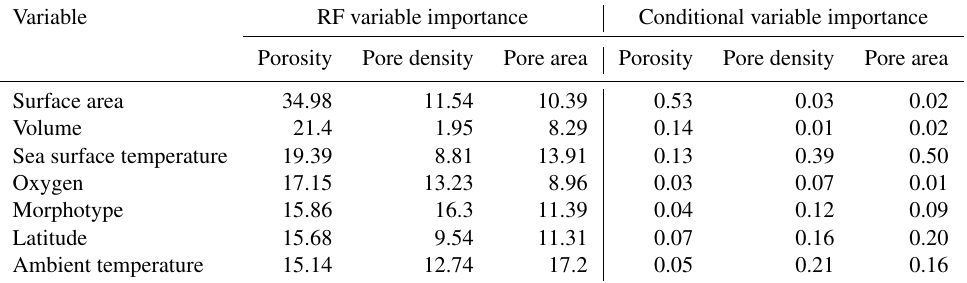
Figure 3. Variable importance plots for the random forest models for each pore characteristic. Importance rankings are based on the increase in error produced when the variable in removed (% incremental mean squared error). Marker size refers to the ranking in the conditional variable importance analyses, with the largest markers denoting the most important variables. Table 2. Variable importance rankings from random forest models and conditional variable importance analysis. Random forest (RF) variable importance values are based on the percent increase in error when the variable is removed from the model. Conditional variable importance values reflect a reassessment of relative variable importance rankings without bias toward factorial or highly correlated